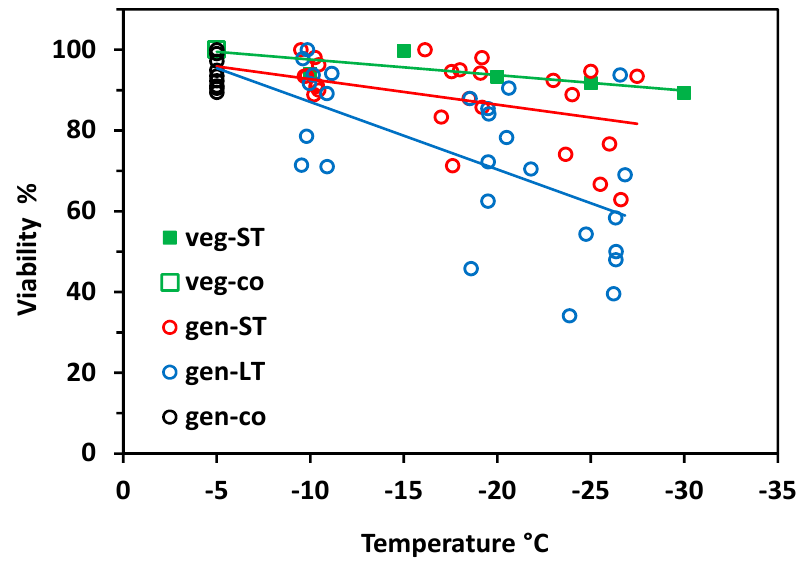
Figure 2. Saxifraga moschata Wulfen. Percent viability (TTC test) of control buds (co) and of vegetative (veg) and generative (gen) buds in the short-time (ST) and long-time (LT) experiment in winter. Vegetative buds (green squares): each symbol refers to the total of investigated vegetative buds pooled from 8–12 individuals per test temperature (ST experiment 1). Generative buds in control individuals (open black circles) and in individuals after ST (red circles) and LT (blue circles) exposure at different freezing temperatures in experiment 2; each symbol refers to a single individual. Trend lines indicate linear regressions.